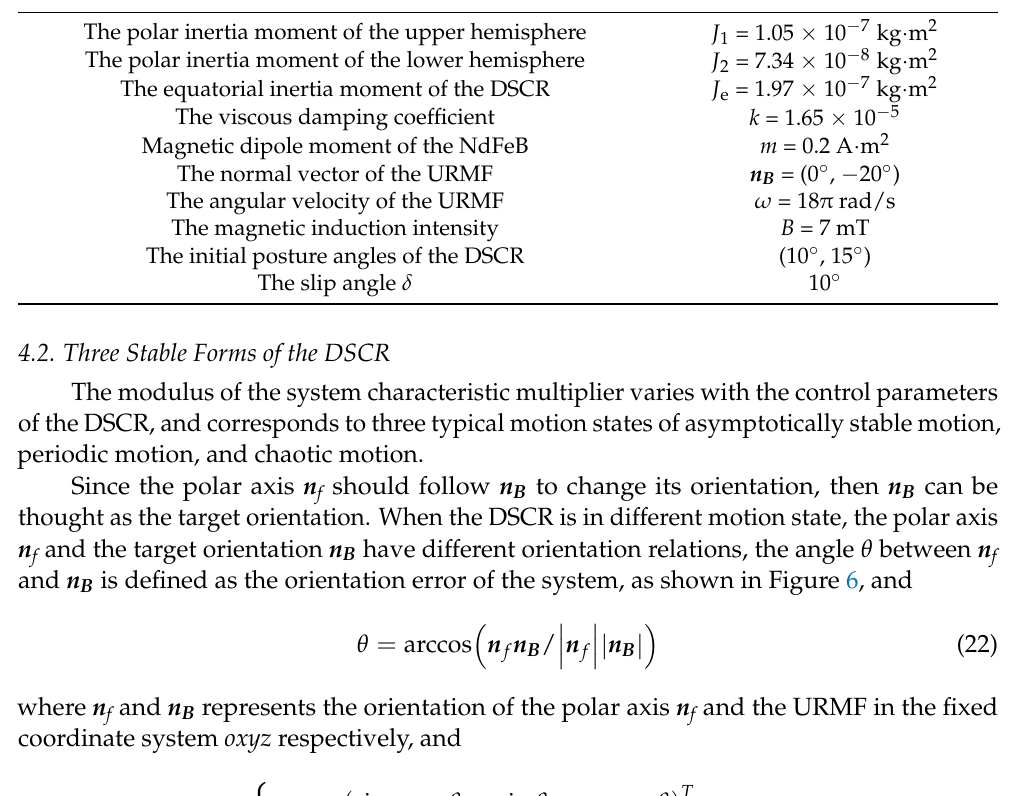
Table 2. The control parameters of the DSCR.